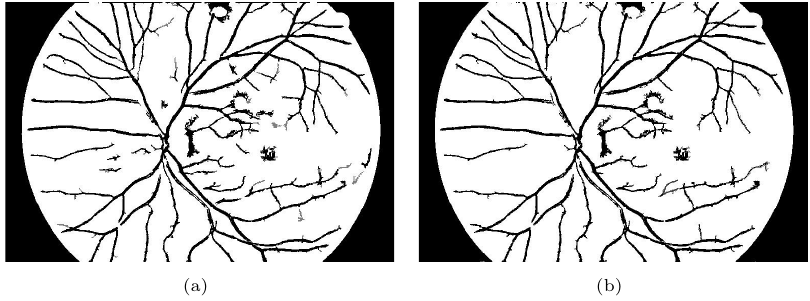
Figure 4. Calculating the threshold: (a) without optimization, (b) with optimization.